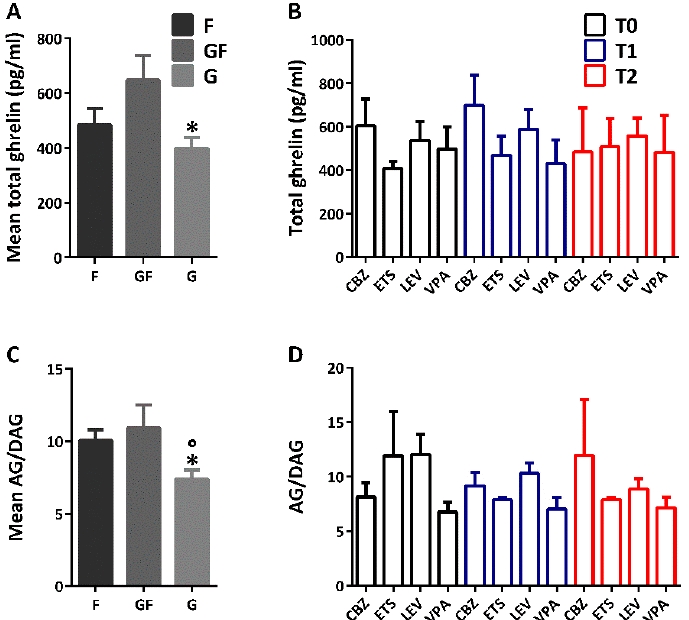
Figure 3. Total ghrelin and ghrelin (AG)-to-des-acyl ghrelin (DAG) ratio in plasma of children with different types of epilepsy and treated with appropriate antiseizure medications (ASMs). In ( A ), significantly low levels of mean total ghrelin plasma levels were reported in generalized epilepsies (G) in comparison to combined generalized and focal (GF) epilepsies. In ( B ), the mean total ghrelin in plasma at basal levels (CBZ, n = 7; ETS, n = 3; LEV, n = 13; VPA, n = 9) was not affected by the type of ASM at T1 (CBZ, n = 6; ETS, n = 2; LEV, n = 11; VPA, n = 8) and T2 (CBZ, n = 3; ETS, n = 2; LEV, n = 9; VPA, n = 4). Significantly low levels of AG-to-DAG ratio were reported only in children suffering from G, in comparison to focal (F) and GF epilepsies ( C ). These findings were also not affected by the time of ASM or time ( D ). * p < 0.050 G vs. GF; ° p < 0.050 G vs. F; Duncan’s method. Abbreviations: CBZ, carbamazepine; ETS, ethosuximide; LEV, levetiracetam; VPA, valproic acid.